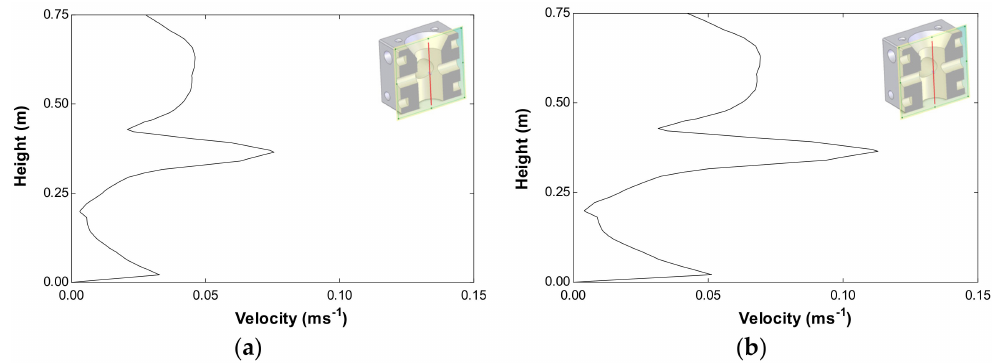
Figure 10. Velocity field in the middle of the AR. Orientation A. ( a ) 0.074 ms − 1 current velocity; ( b ) 0.110 ms − 1 current